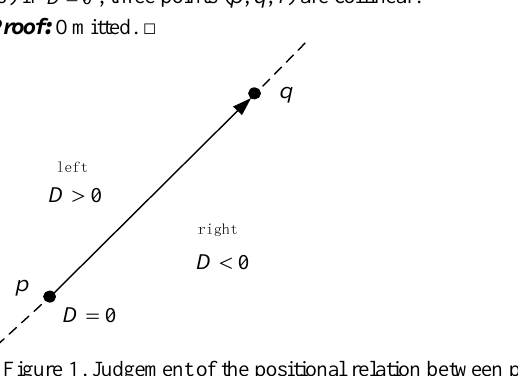
Figure 1. Judgement of the positional relation between point and straight line